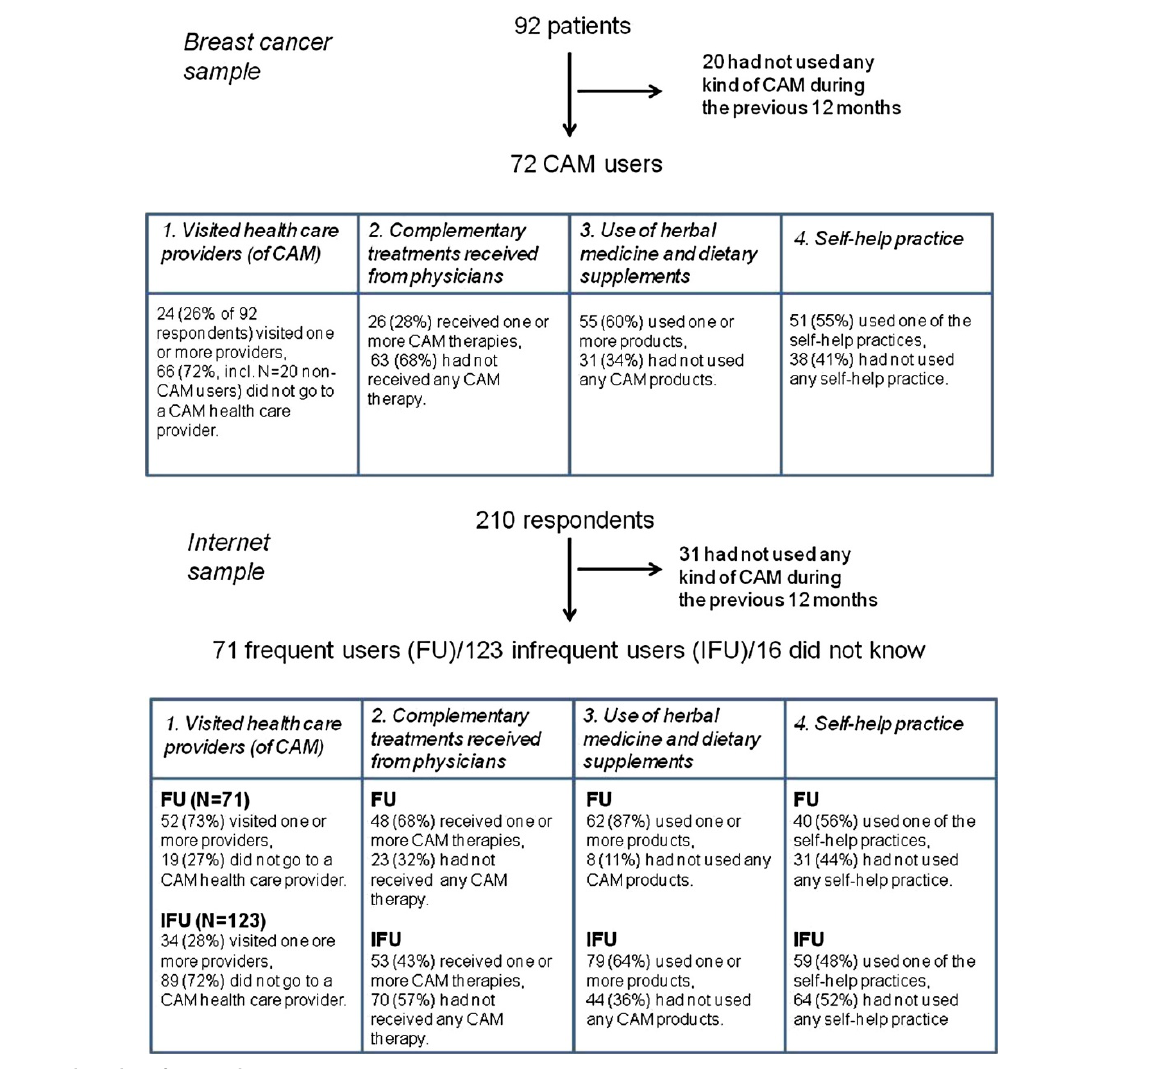
Figure 2 Flow chart for